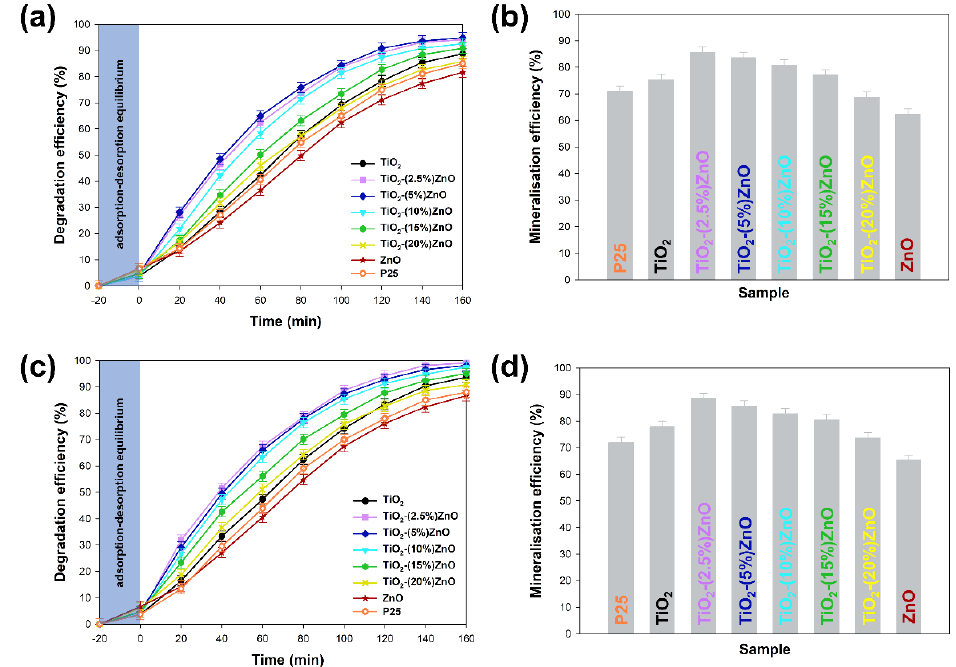
Figure 12. The results of degradation and mineralization of 4-chlorophenol with used 10W ( a , b ) and 20W ( c , d ) UV-LED light source.